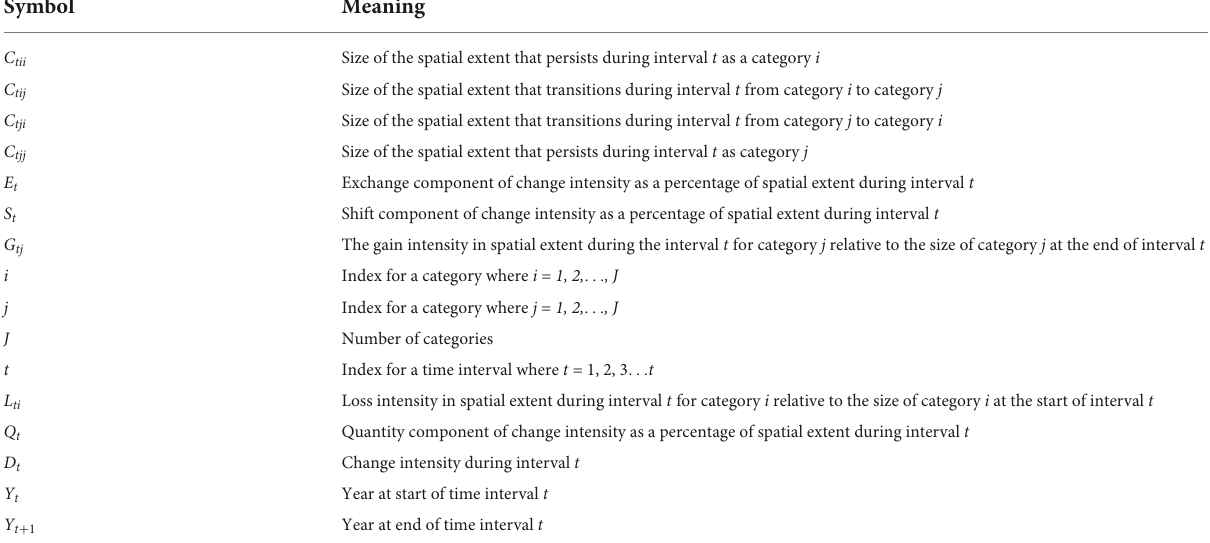
TABLE 2 Mathematical notations of the categorical intensity analysis. Symbol